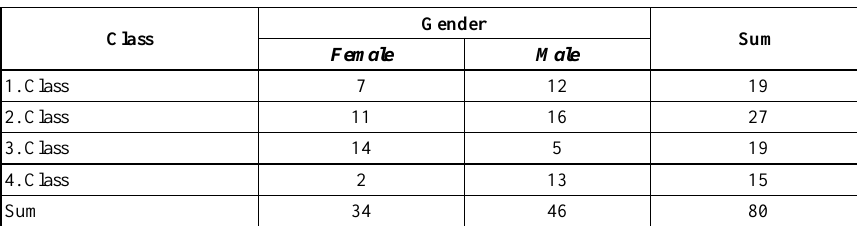
Table 1. Demographic characteristics of students